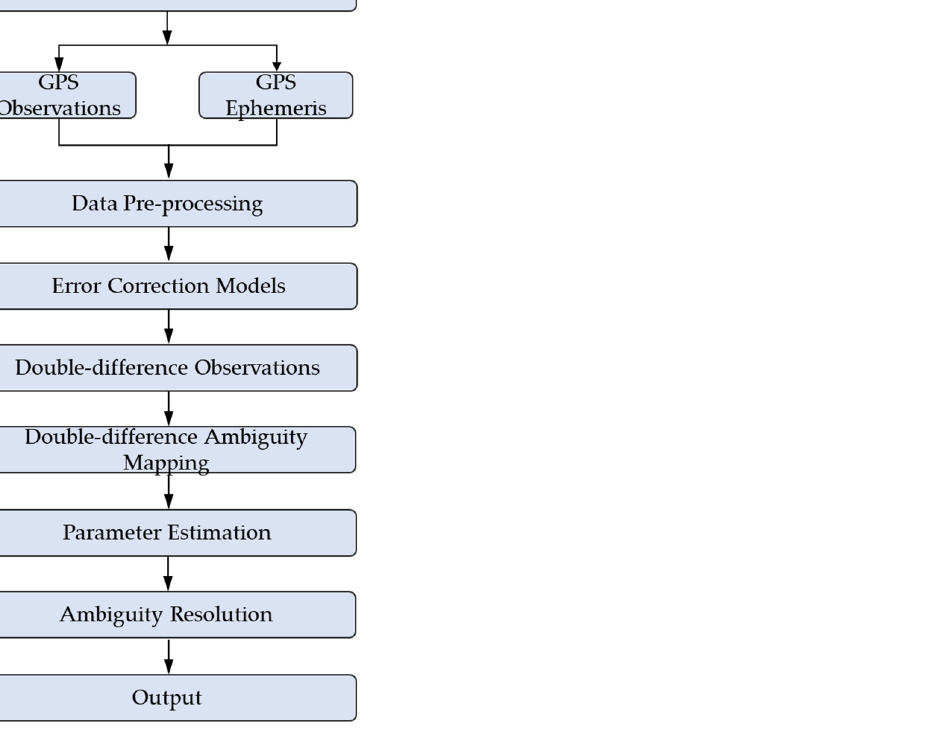
Figure 3. Data processing flowchart. The red square indicates the reference station, and the blues are monitoring stations. Table 2. GPS data processing